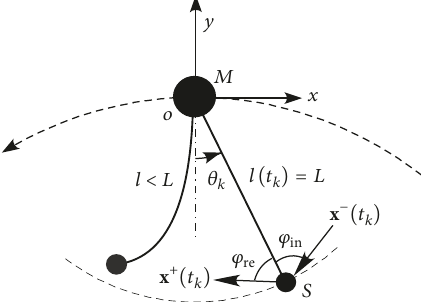
Figure 2: Impact process of a tethered subsatellite